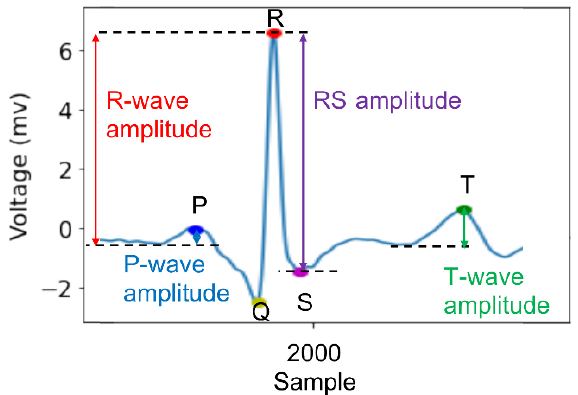
Figure 1. Illustration of ECG waves.